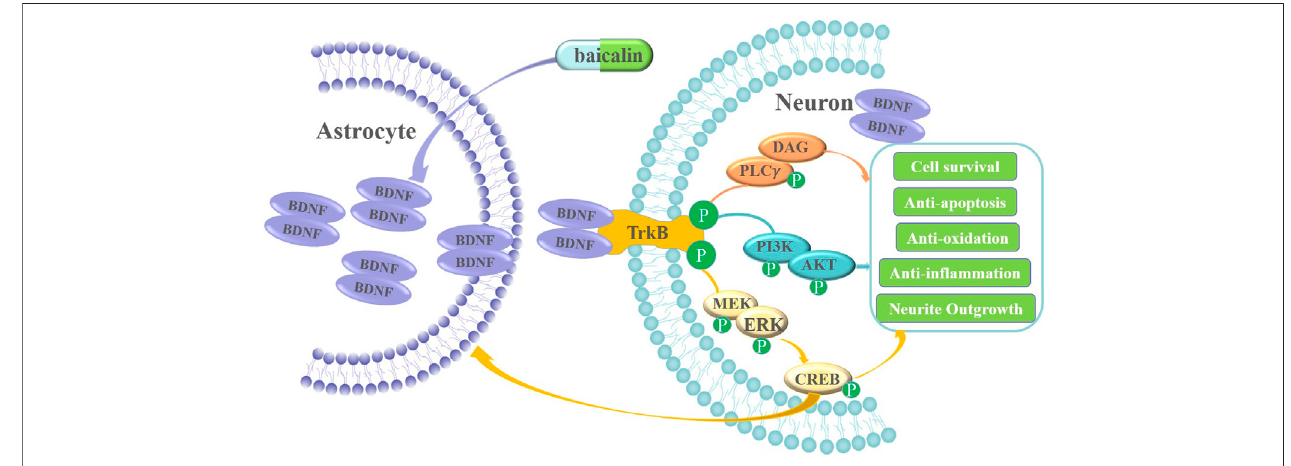
FIGURE 11 | Scheme of the neuroprotective mechanism of BCL after